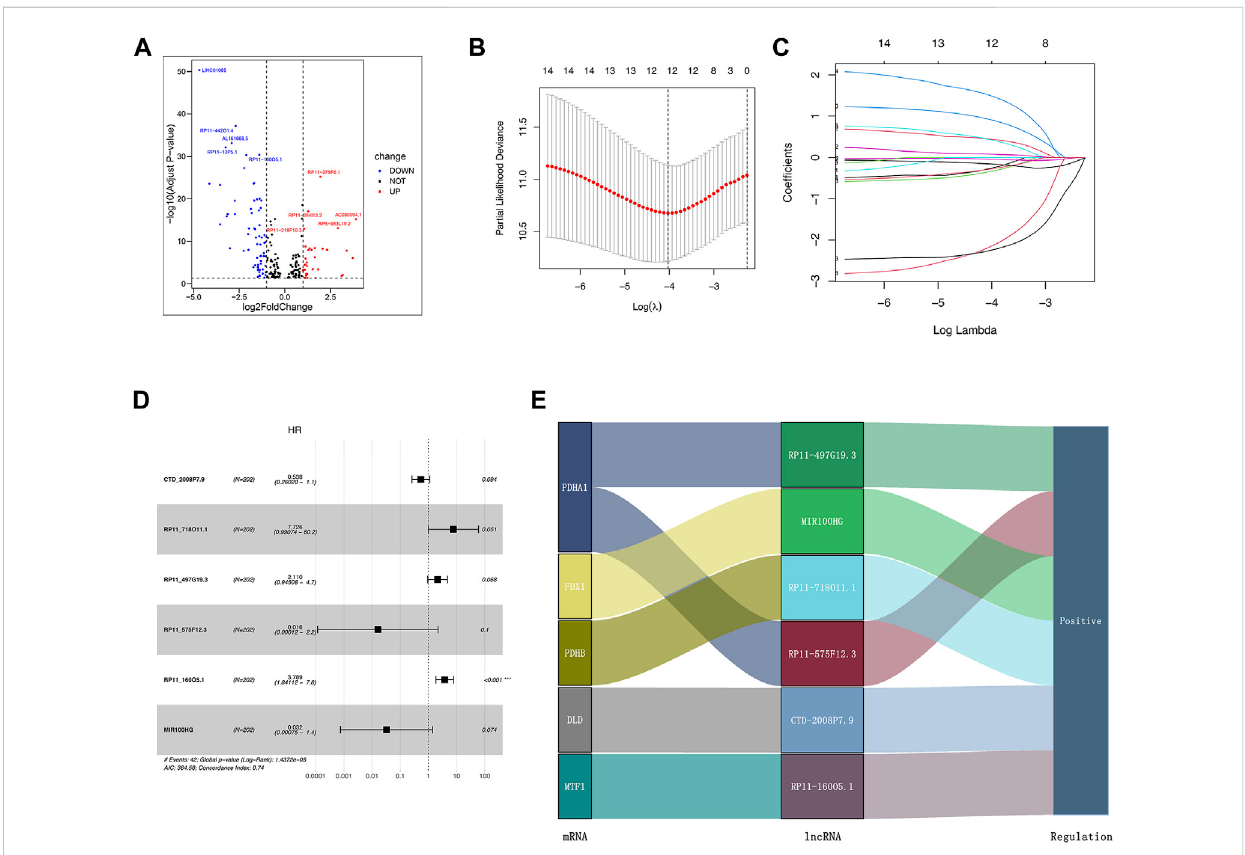
FIGURE 3 Establishment of the crlncRNA signature prognostic model. (A) The volcano plot of 101 DE-crlncRNAs. (B) The 10-fold cross-validation for variable selection in the LASSO algorithm. (C) The LASSO coef fi cients of six crlncRNAs. (D) Multivariate Cox regression showed six crlncRNAs. (E) The Sankey diagram indicated the correlations of the cuproptosis-related genes and six